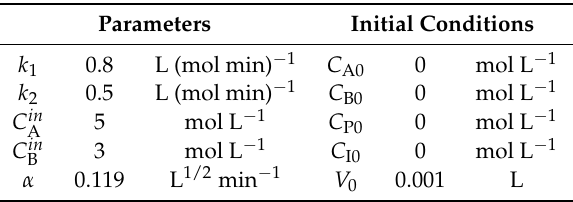
Table 5. Constants and initial conditions for the model